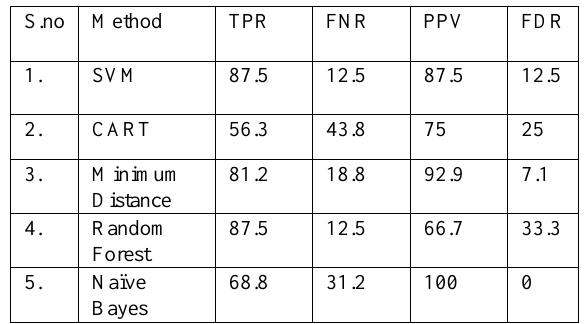
Table 1. Confusion matrix of the landslide identification using different Machine learning Algorithm